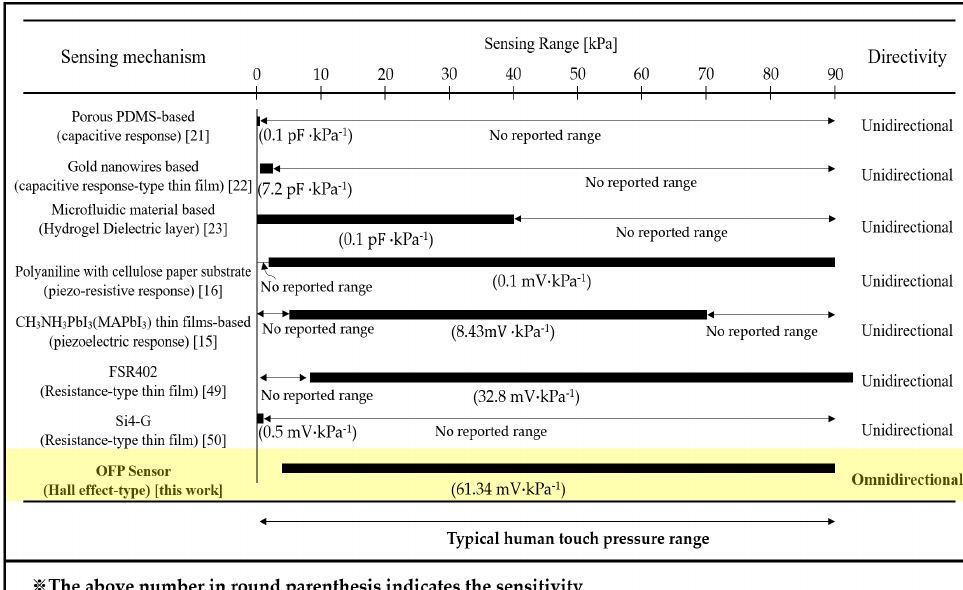
Figure 4. Comparison of the sensitivity and sensing mechanisms of various pressure sensors.